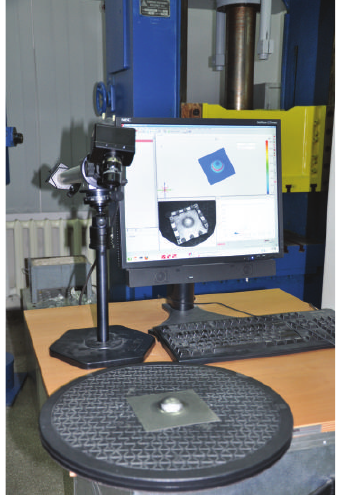
Figure 2: The Argus optical measurement system used for strain and thickness reduction